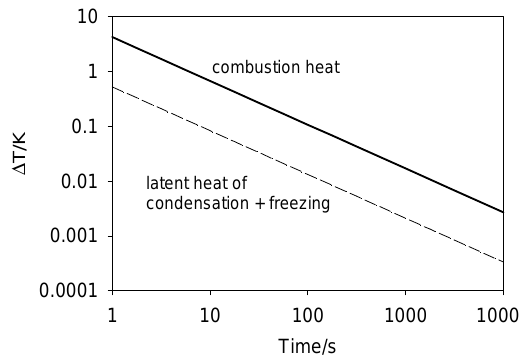
Fig. A5. Temperature increases due to combustion-heat and latent- heat releases versus